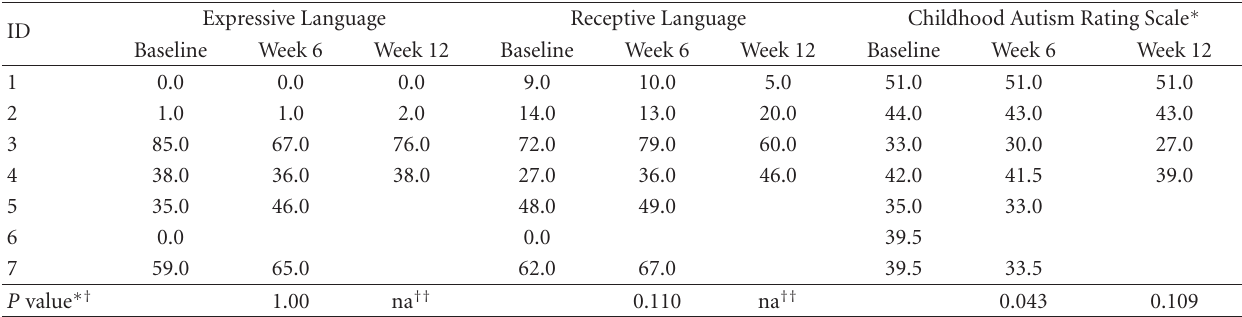
Table 3: Language and autism behavior ratings over the course of the study for each study participant.